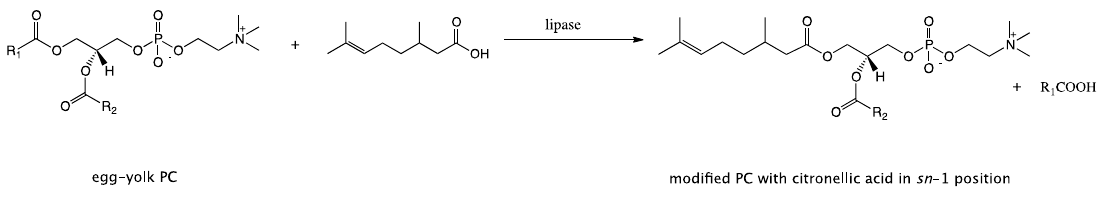
Figure 1. Lipase-catalyzed acidolysis of egg-yolk phosphatidylcholine with citronellic acid.